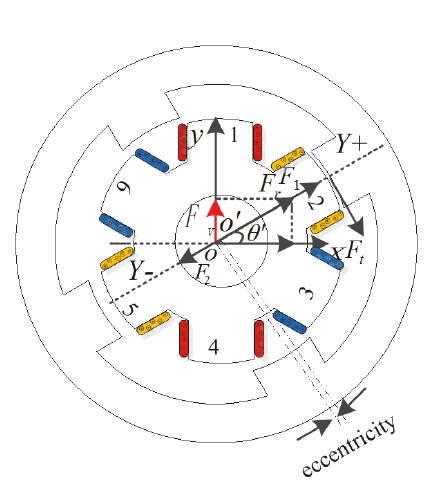
Figure 1: SRM vertical